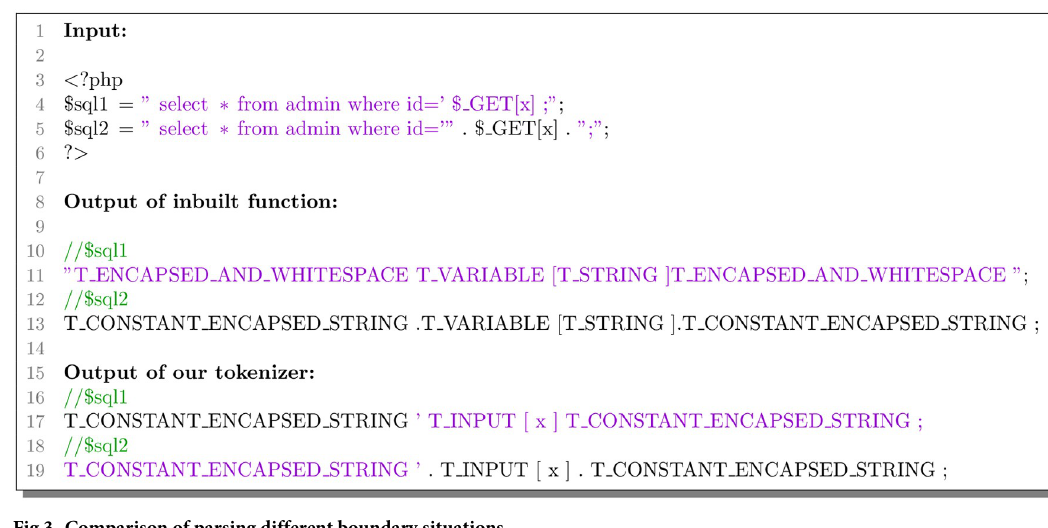
Fig 3. Comparison of parsing different boundary